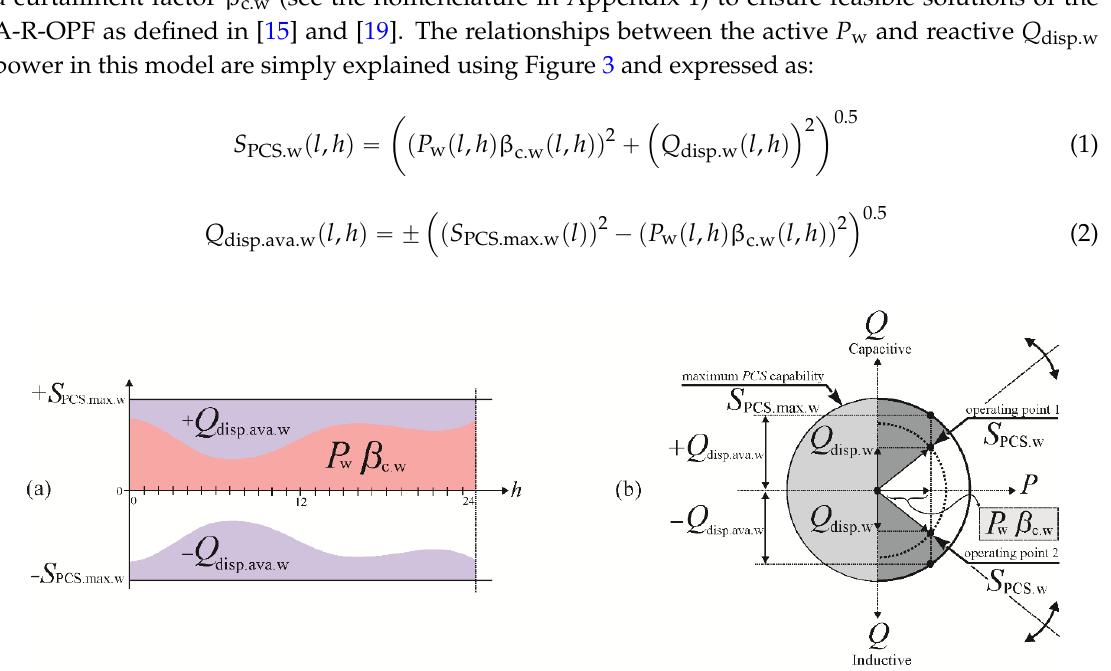
Figure 3. ( a ) Illustration of the behaviors of active/reactive powers through an ideal power conditioning system (PCS) [2]; and ( b ) the capability diagram of a PCS [2,22], where the dark-area stands for varying limits on power factors (PFs).